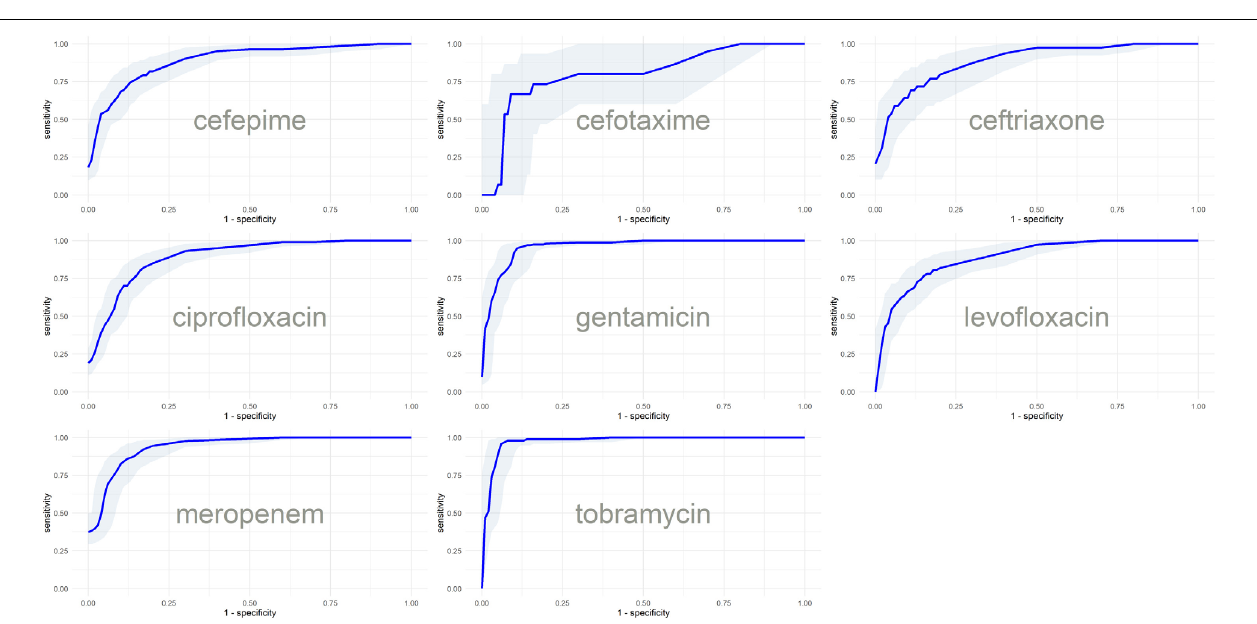
FIGURE 4 | ROC curves with confidence intervals of the final models based on the predictions of test